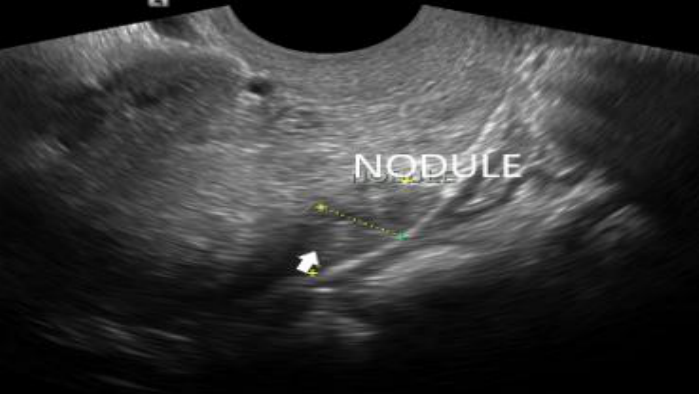
Figure 6. In the sagittal plane, the stretched, normal uterosacral ligament (yellow arrow) appears as a thin white line. The presence of a small amount of free fluid (red arrow) facilitates the visuali- zation.